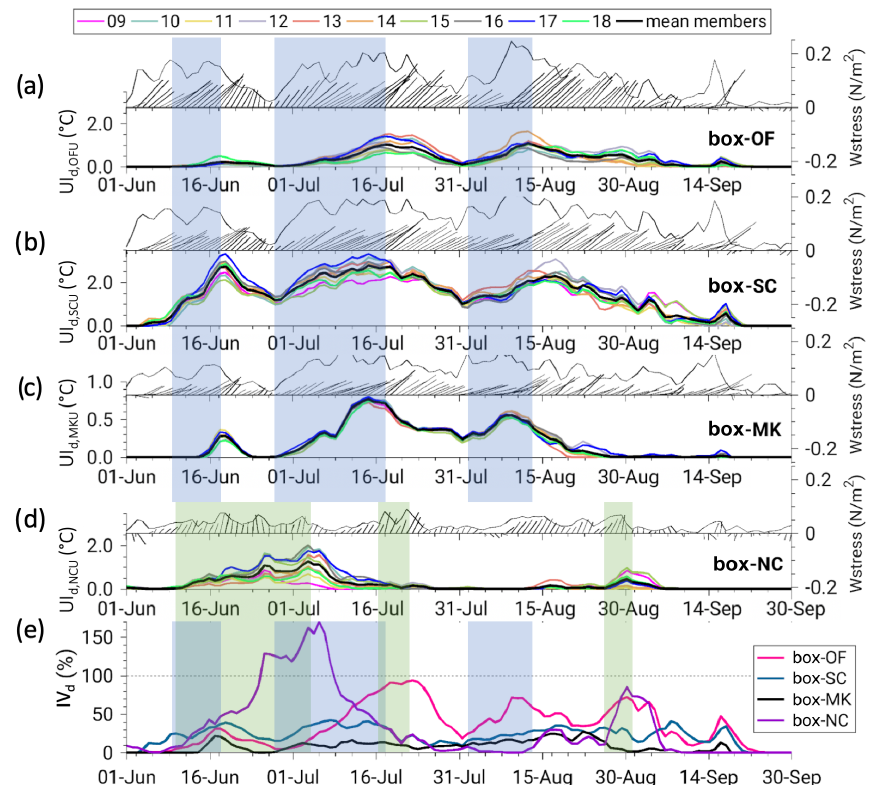
Figure 2. (a, b, c, d) Daily time series between 1 June and 30 September 2018 of direction (arrows) and intensity (black line) of spatially averaged wind stress (Nm − 2 ) over each upwelling area, and time series of UI d , boxN for each simulation (colored lines) and for the ensemble average (black thick line) for each upwelling area ( a , boxSC; b , boxOF; c , boxMK; d , boxNC). (e) Daily time series of IV d (UI d , boxN ) for each upwelling area. Periods covering the OFU, SCU and MKU development are highlighted in blue. Periods used to study the MKU development are highlighted in